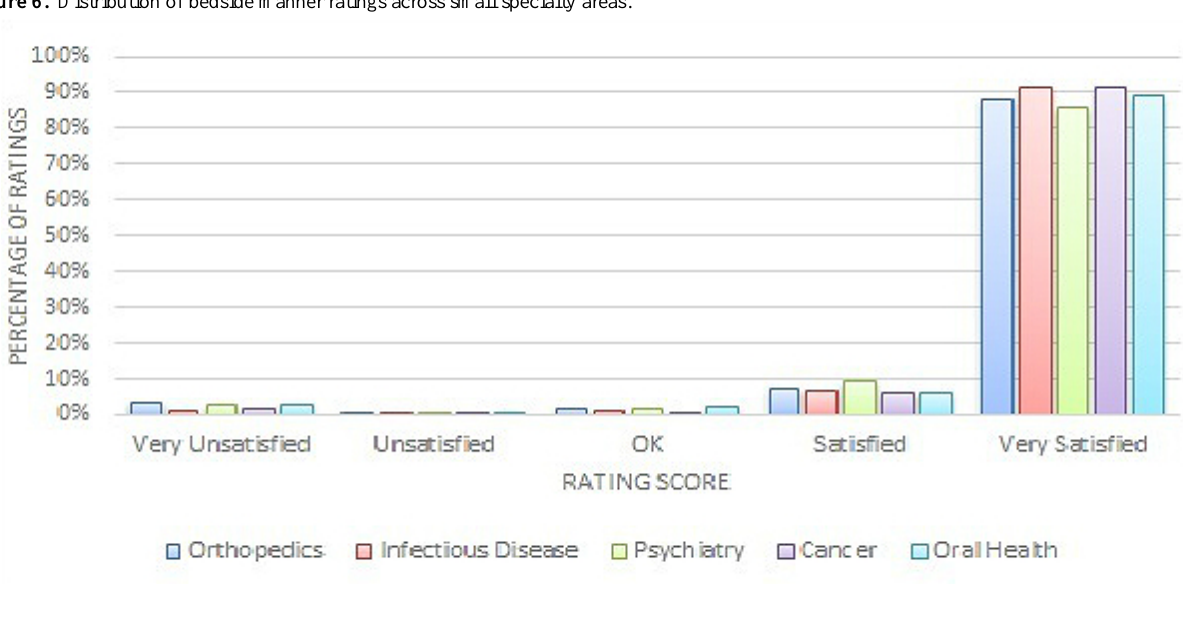
Figure 6. Distribution of bedside manner ratings across small specialty